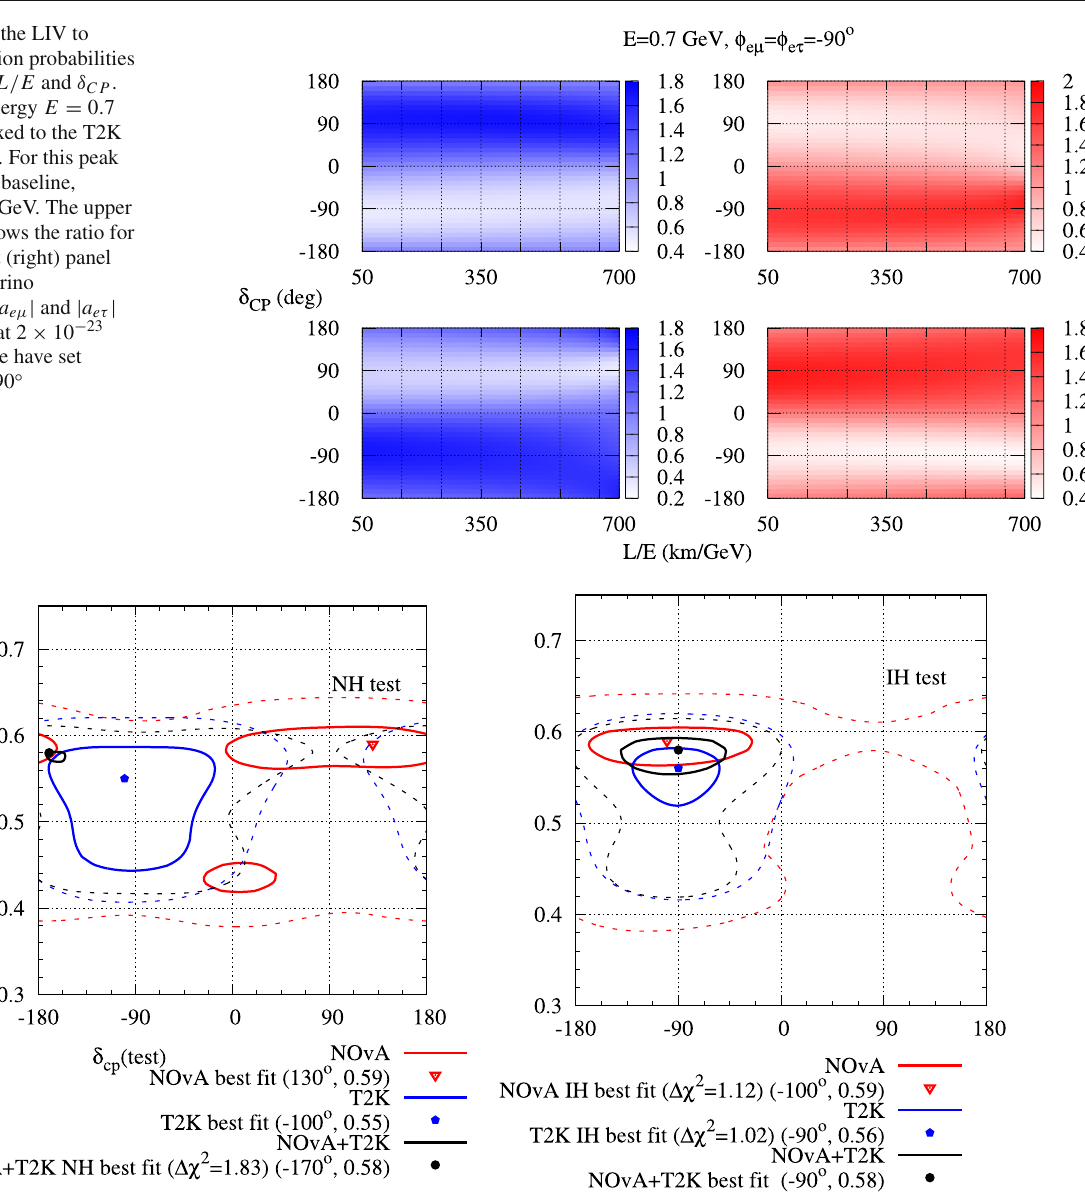
Fig. 9 Allowed region in the sin 2 θ 23 − δ CP plane after analysing NO ν A and T2K complete data set with standard matter effect with- out LIV hypothesis. The left (right) panel represents test hierarchy NH (IH). The red (blue) lines indicate the results for NO ν A (T2K)